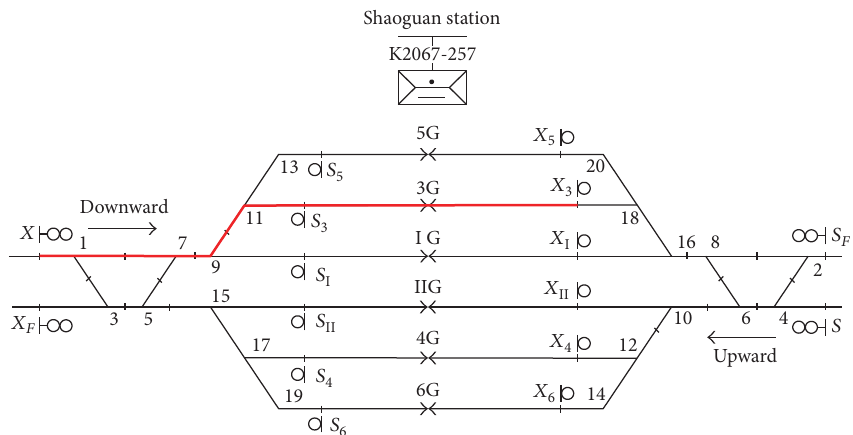
Figure 5: The plane layout of signals of Shaoguan station.